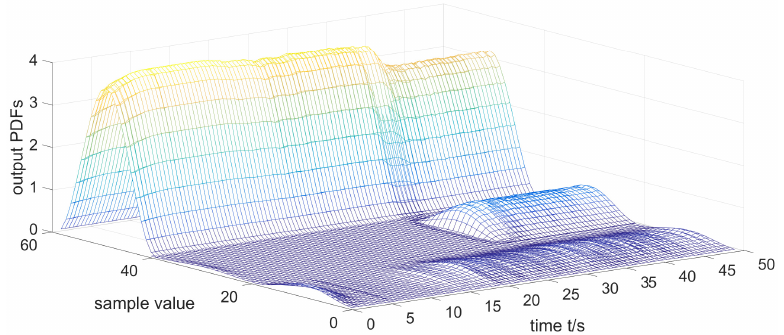
Figure 2. The 3D mesh of output PDFs when F 1 = F 2 = 0.